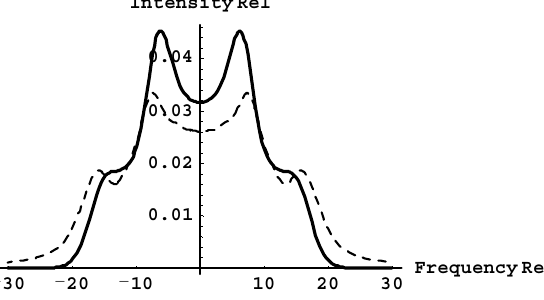
Figure 5. The same as Figure 4 but for stronger Langmuir waves, corresponding to ε = 3.